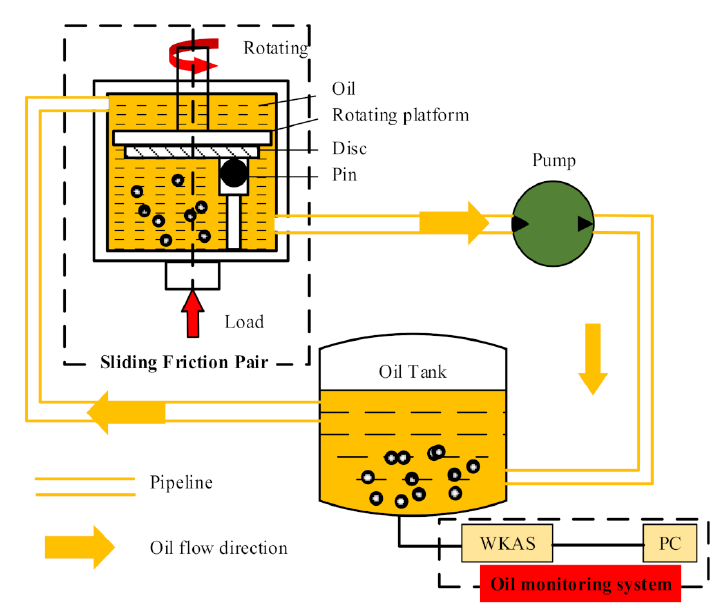
Figure 6. Functional diagram of offline oil monitoring experiment on a pin–disc test